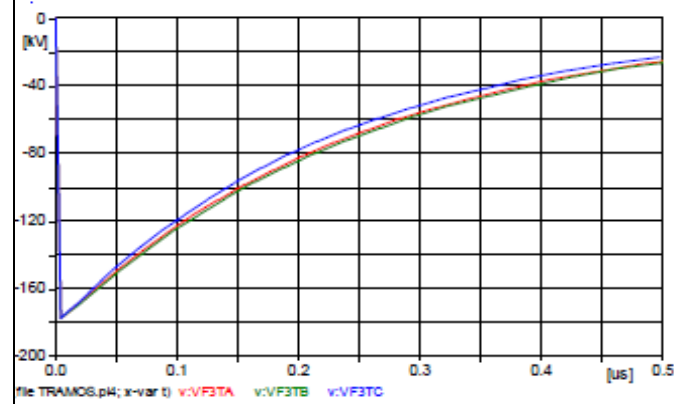
Figura 8: Tensión inducida en una línea no uniforme modelada mediante tres tramos uniformes de igual